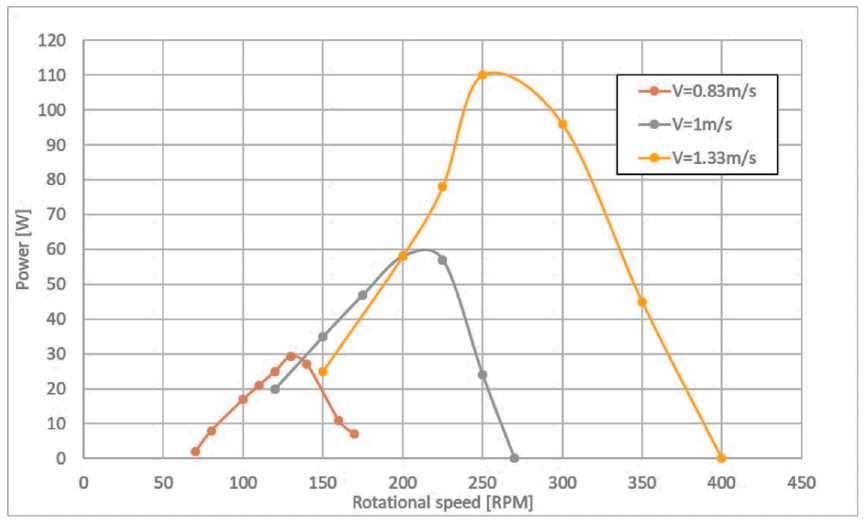
Figure 1. Power curves for a shrouded hydrokinetic turbine at different water velocities [21].